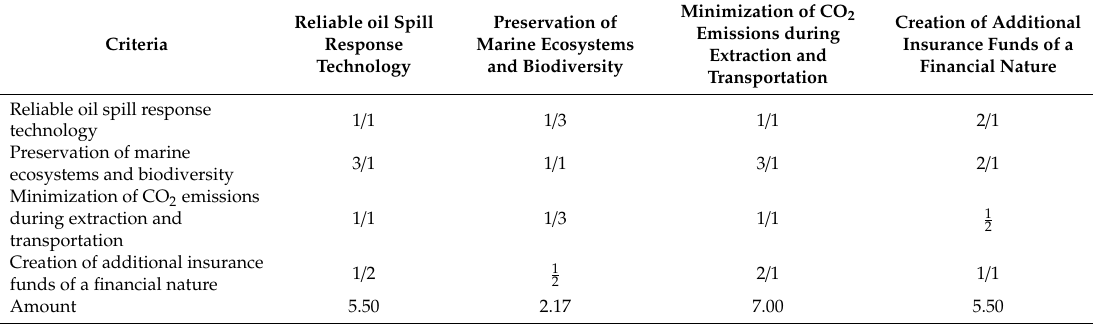
Table A6. Results of the assessment of the relative importance of environmental sustainability criteria.